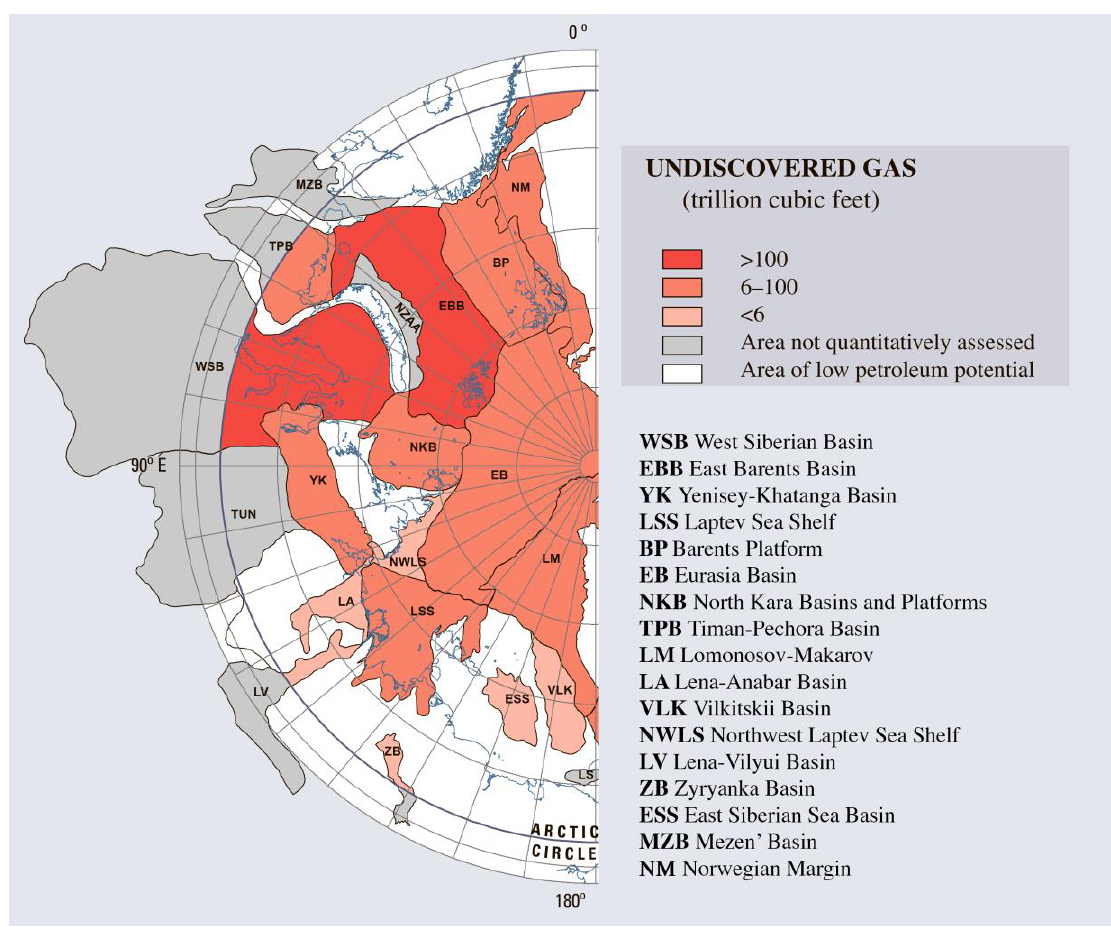
Figure 14. Provinces in the Circum-Arctic Resource Appraisal for mean estimated undiscovered gas, after [54].